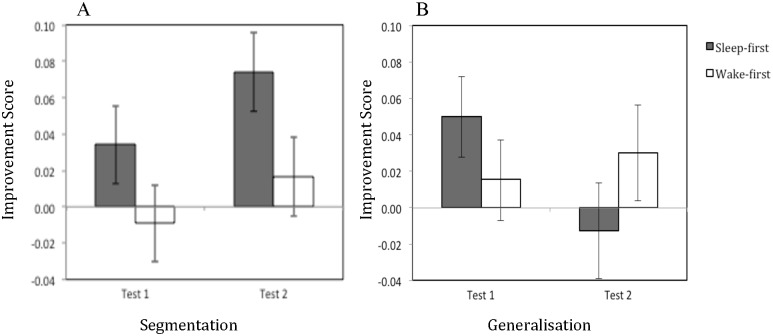
Mean improvement scores for the segmentation (panel A) and generalisation (panel B) tasks at each test phase, given for each condition.Error bars show Standard Error.